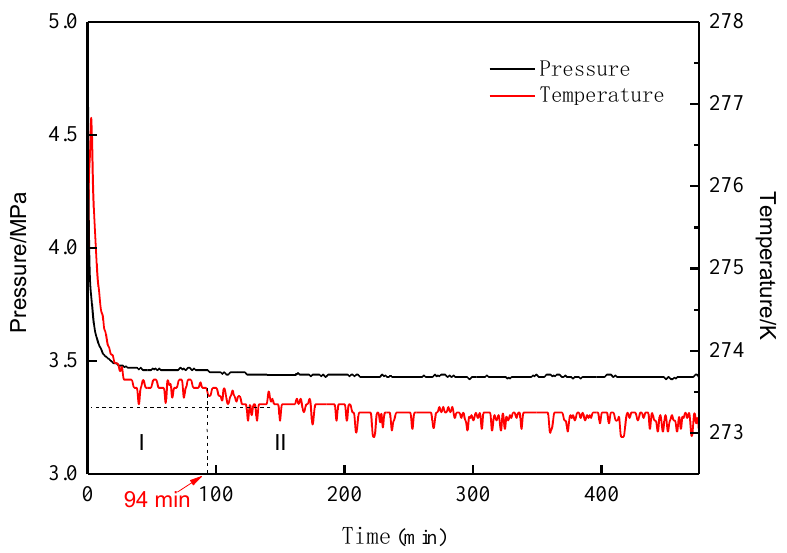
Figure 3. The CP-CO 2 system pressure and temperature curves at 5.0 MPa.